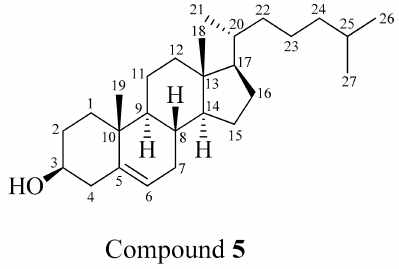
Figure 5. Chemical structure of compound 5 ,